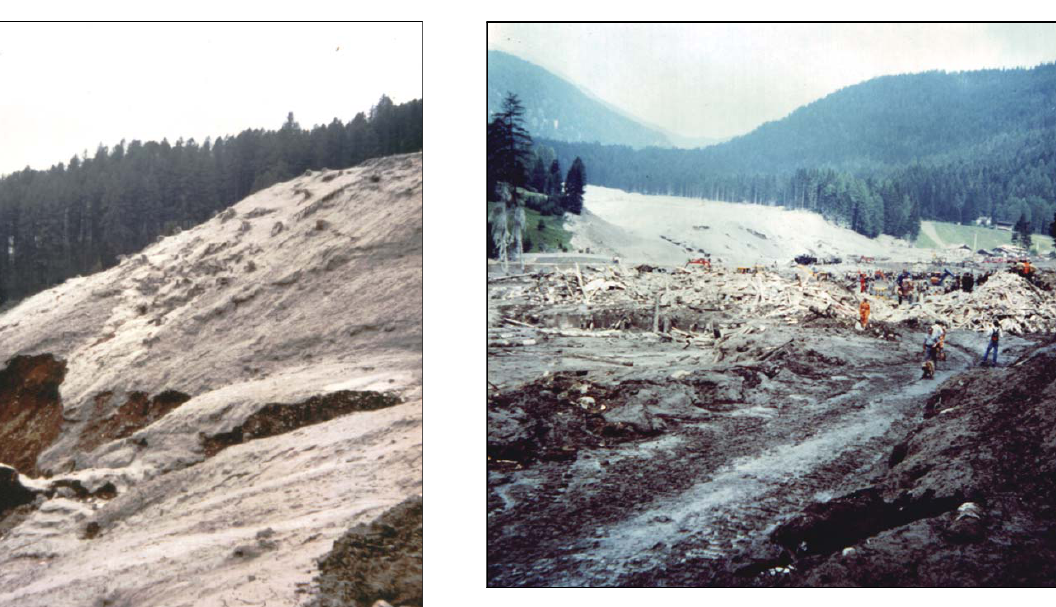
Fig. 9 – A slope sector at the foot of the Pozzole basins, just upstream the Stava village. The photograph shows a thin layer of mud left behind as the mudflow moved downstream. The effects on the ground and the destructive effects on forest cover are also visible (photograph CNR-IRPI Torino, 20 July 1985).